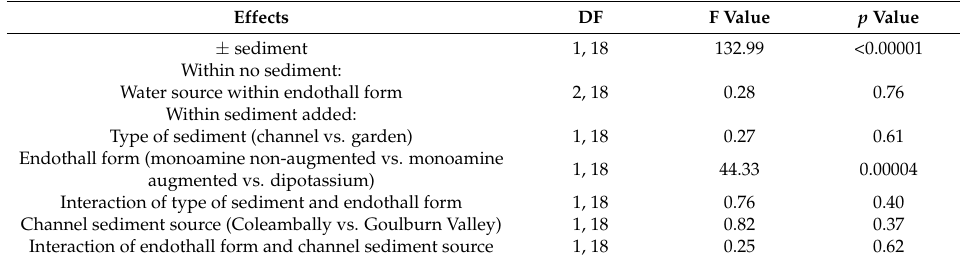
Table 7. Analysis of variance for isomer-2 at day-21, as % decline at day-0. The data is analyzed after a rank with ties transformation on treatments with monoamine endothall. All p values are calculated using permutation tests on the F statistic on rank transformed data. DF = Degrees of